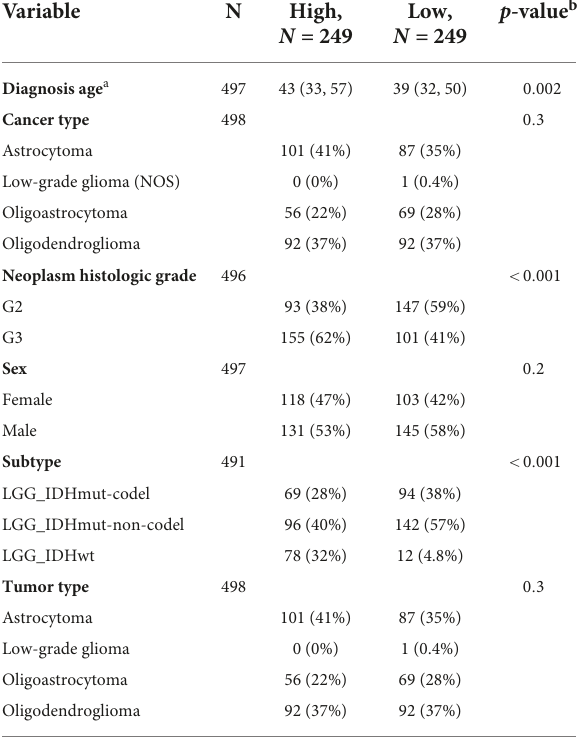
TABLE 1 The association with TFRC and clinicopathological characteristics in TCGA-LGG patients. Variable